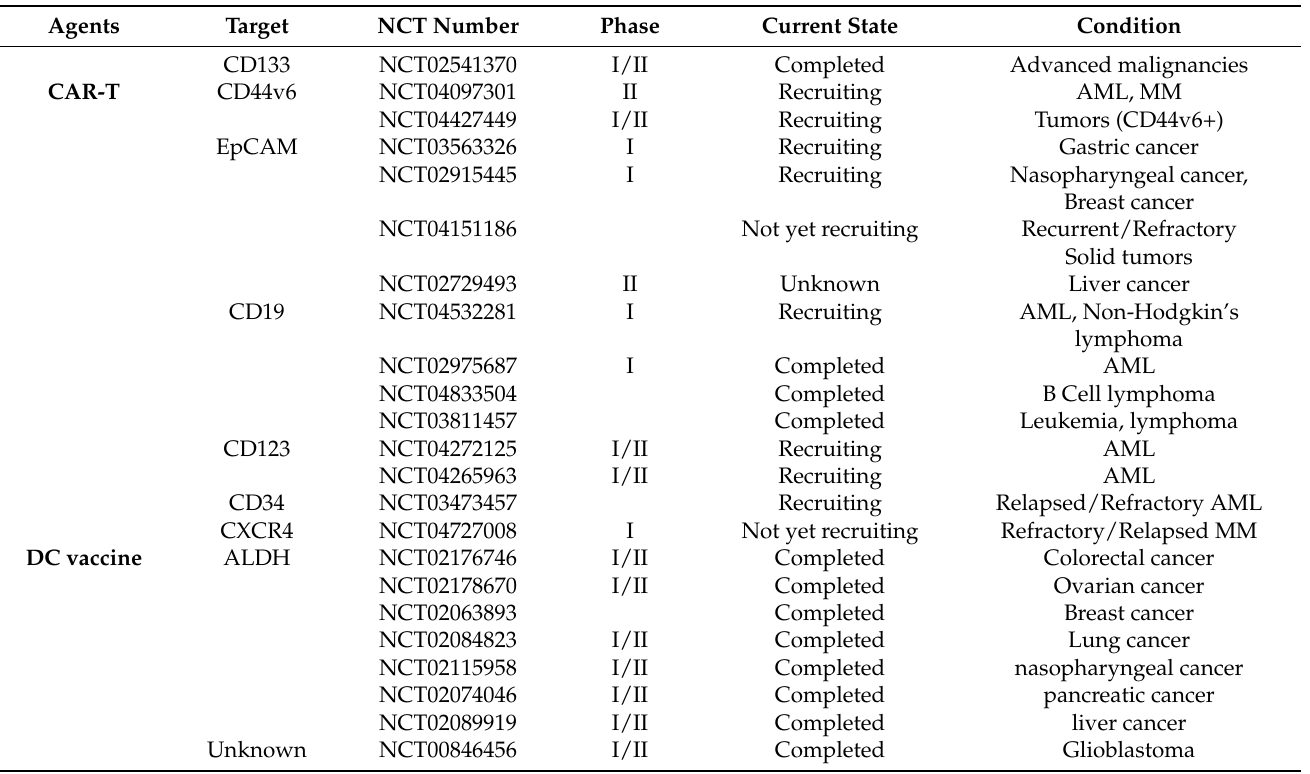
Table 6. Immunity methods targeting CSCs which have been evaluated in clinical trials.